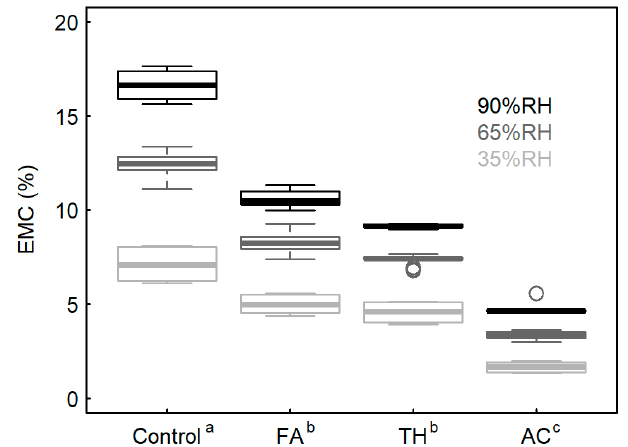
Figure 5. Equilibrium moisture content (EMC) values measured for each sample, and at different humidity levels (excluding the first humidity cycle). Superscripted letters on the x -axis indicate significant differences according to Tukey’s HSD test (95% confidence level). EMC values for all humidity conditions were pooled when calculating the significance